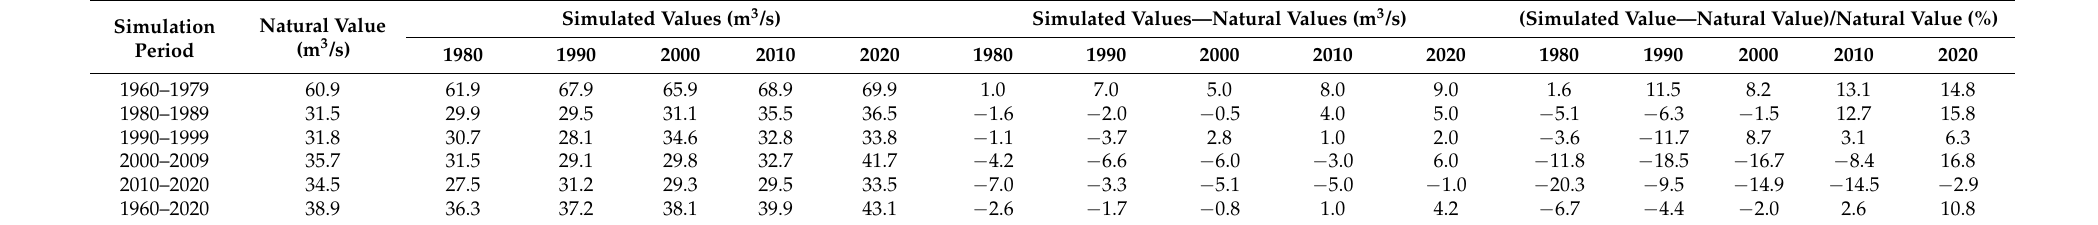
Table 8. Comparative analysis of simulated and natural values of annual runoff under different land-use scenarios. Simulation